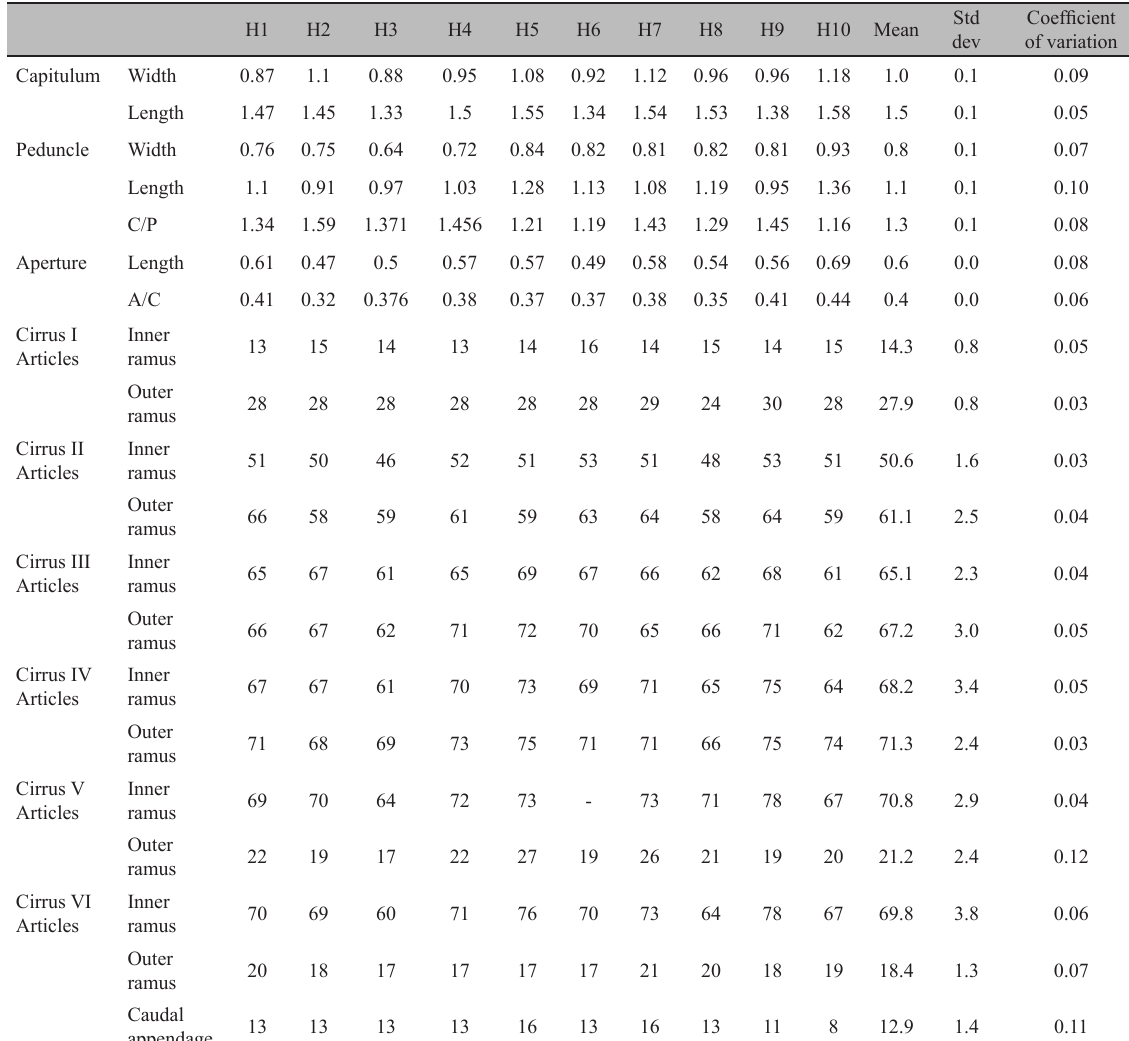
Table 1. External and internal morphological variation for specimens analyzed in this study. (- lack of